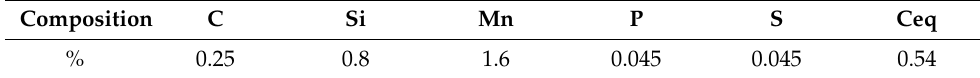
Table 1. Composition of